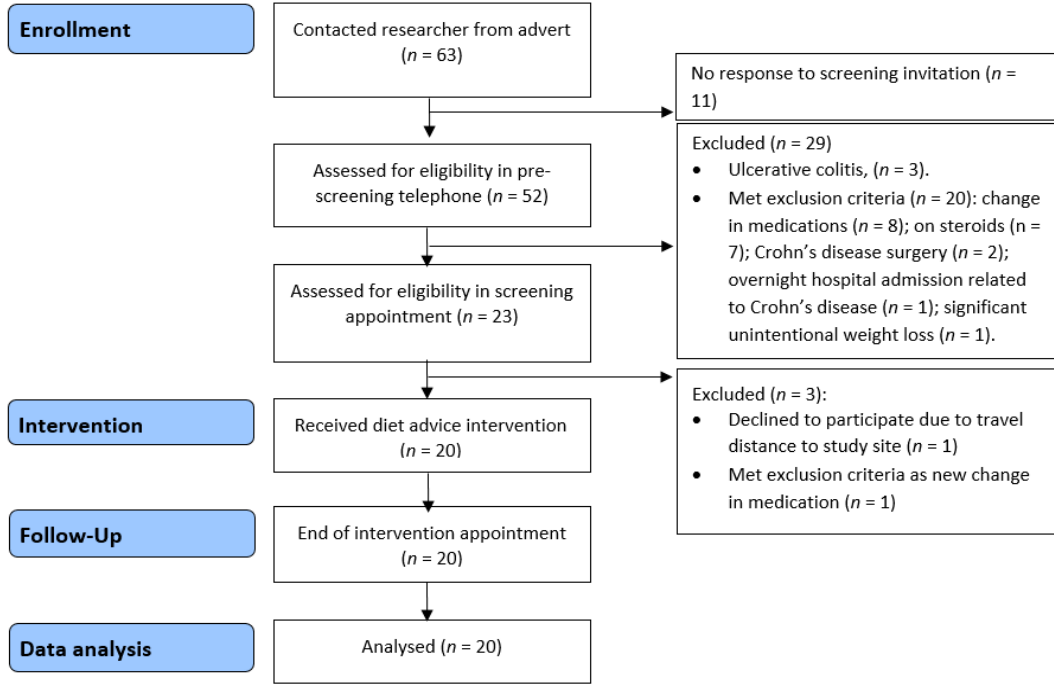
Figure 4. Feasibility study recruitment flow diagram.